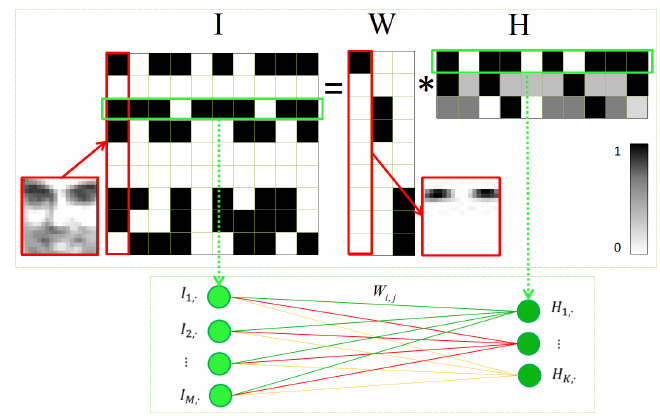
Figure 2. The illustration of Non-negative Matrix Factorization (NMF) model and the obtained analytical components, with the red rectangles denoting column-wise analysis (inducing bases and encodings) and the green rectangles denoting row-wise analysis (inducing hidden